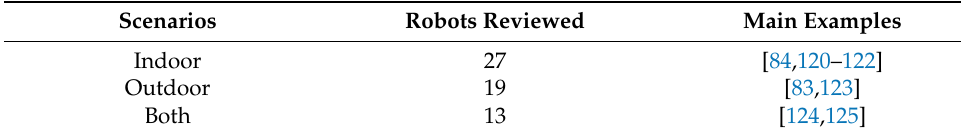
Table 3. Application scenarios of agricultural robots.